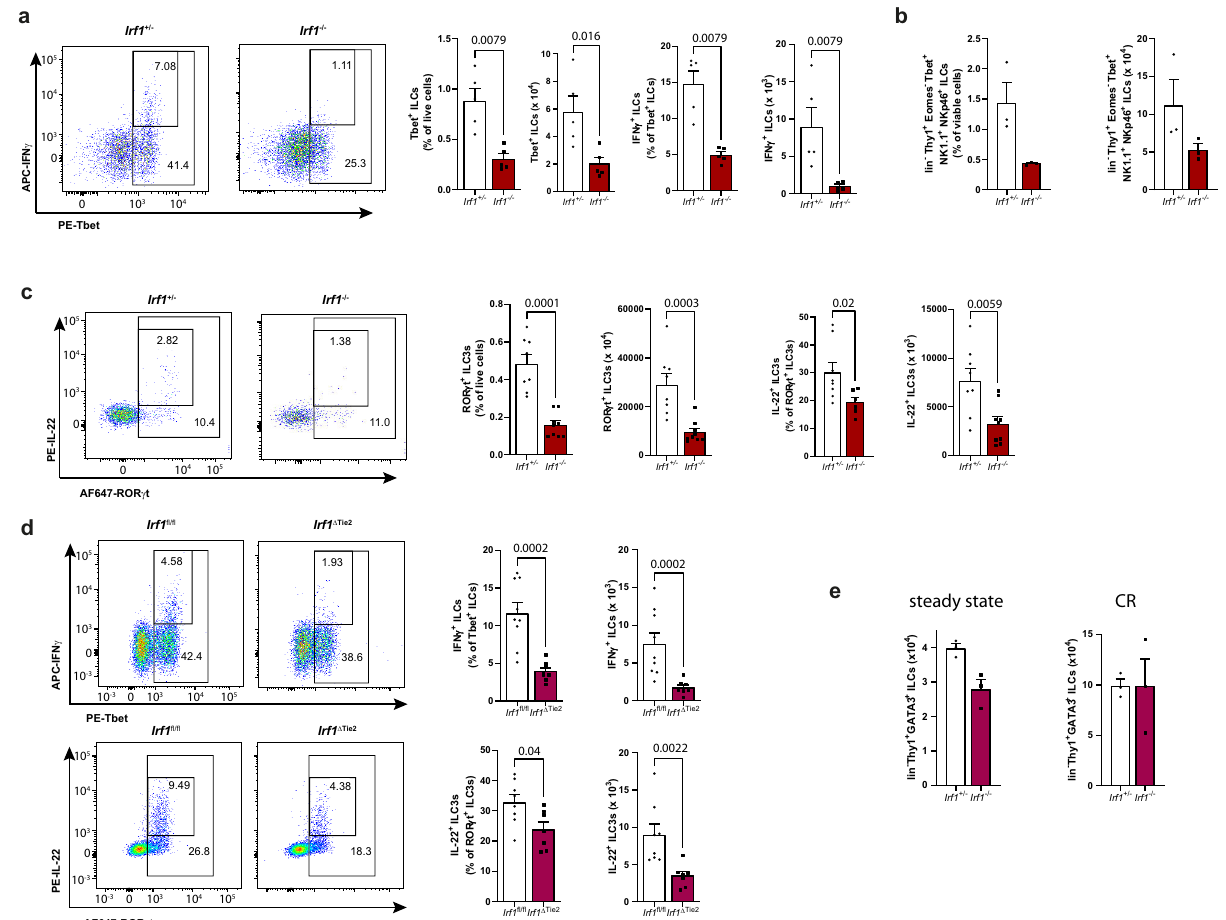
Fig. 5 | Irf1 expression regulates cytokine responses of intestinal innate lym- phoid cells. a – d Irf1 – / – and Irf1 +/ – control or Irf1 Δ Tie2 and Irf1 fl / fl control mice were infected with C. rodentium . LPMCs were isolated at 8 dpi and analyzed by fl ow cytometry. Graphs show relative abundances and frequencies of Tbet + ILCs (lin - Thy1.2 + Tbet + ), IFN- γ producing Tbet + ILCs (lin - Thy1.2 + Tbet + IFN- γ + ), ILC1s (lin - Thy1.2 + Tbet + EOMES - NK1.1 + Nkp46 + ) as well as relative abundances and frequencies